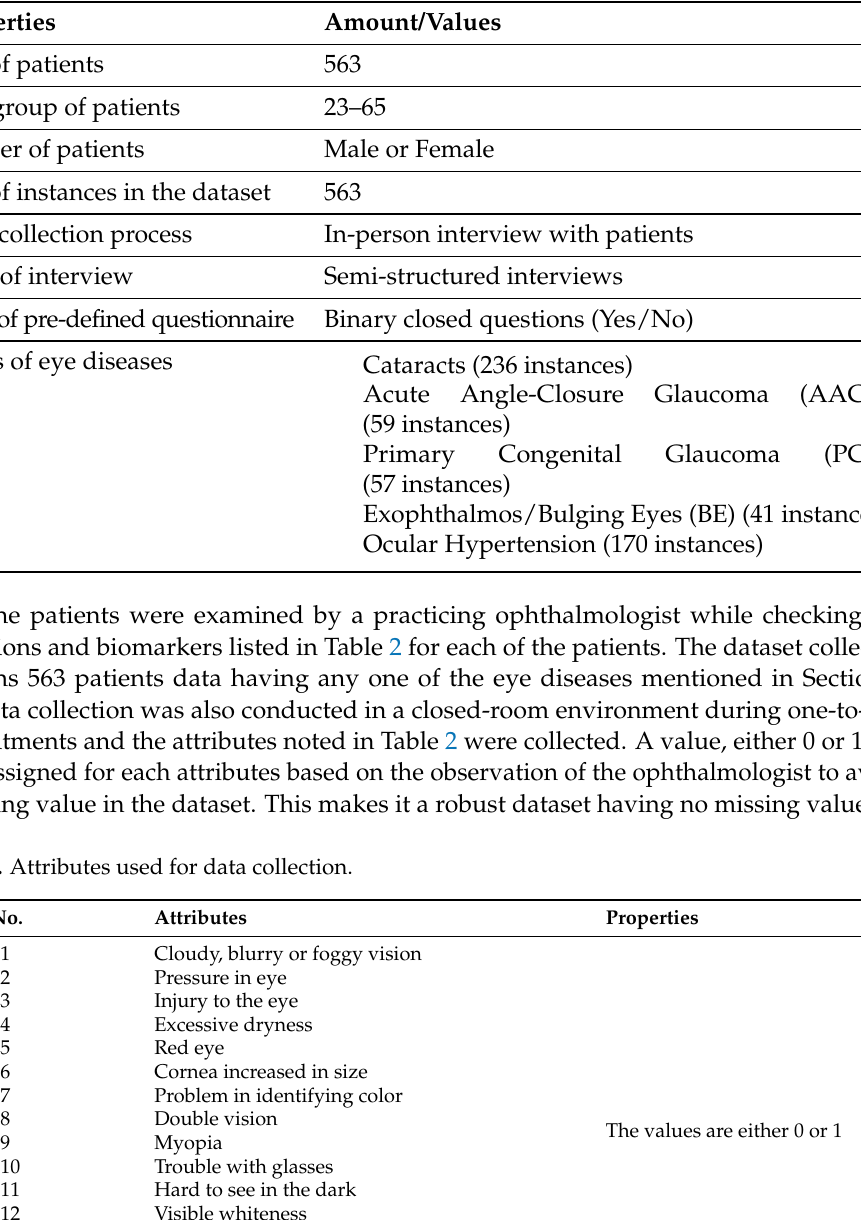
Table 1. Statistical Properties of Dataset.